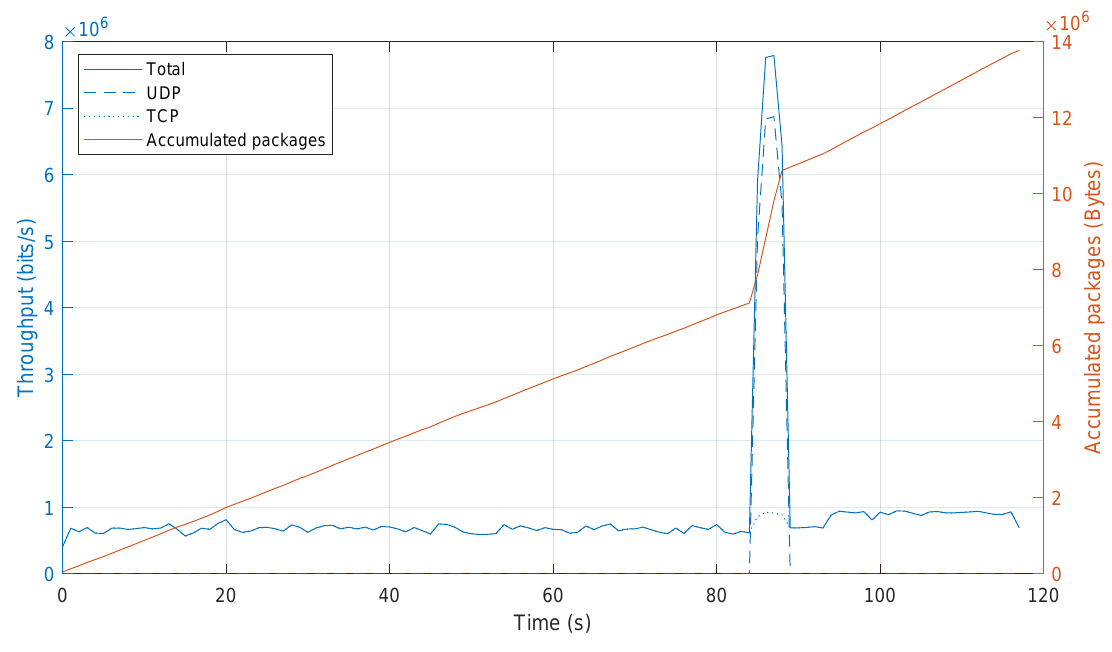
Figure 12. Throughput values during a DDoS